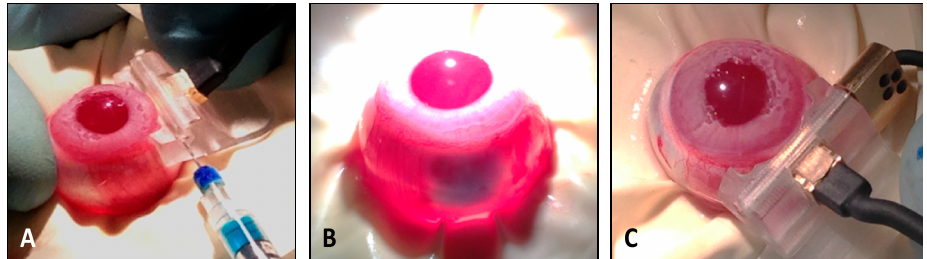
Figure 1. Ciliary muscle electrotransfection procedure in rabbit. ( A ) Plasmid injection in the rabbit ciliary muscle was performed using a dedicated ocular device placed on the nasal scleral surface. ( B ) Tracer dye (blue) was used for the demonstration purpose only and was not used during administration of pEYS611. ( C ) Following adjusted placement of the ocular device so that its superior part fits with the limbus, the comb electrode was inserted into ocular tissues until its stop position.